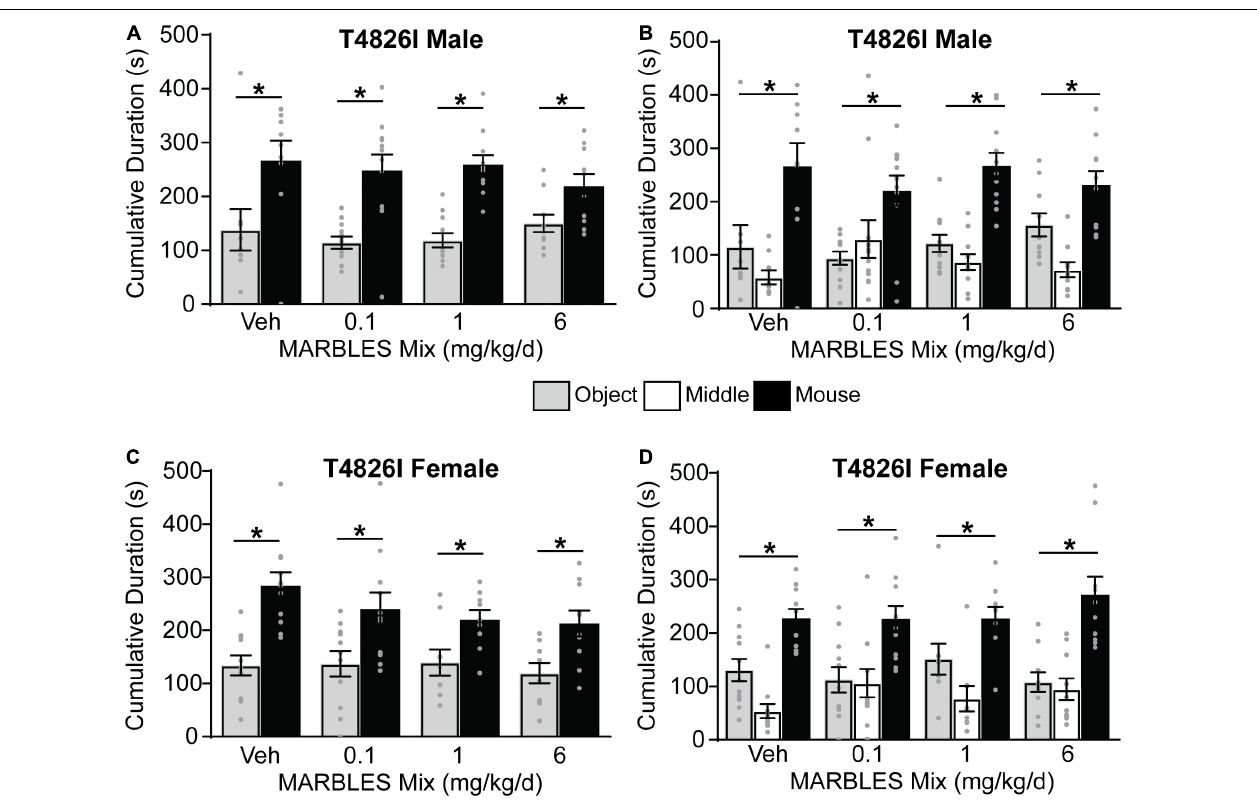
FIGURE 4 | Developmental exposure to the MARBLES PCB mix did not affect social behavior in T4826I mice. (A,C) The amount of time males (A) or females (C) spent sniffing either a novel sex- and age-matched mouse or a novel object. (B,D) The amount of time males (B) or females (D) spent on each chamber side. Data presented as mean ± SEM ( n = 9–12). * Indicates significant difference between novel mouse vs. novel object at p < 0.05 as determined using an unpaired t -test, Mann-Whitney test or unpaired t -test with Welch’s